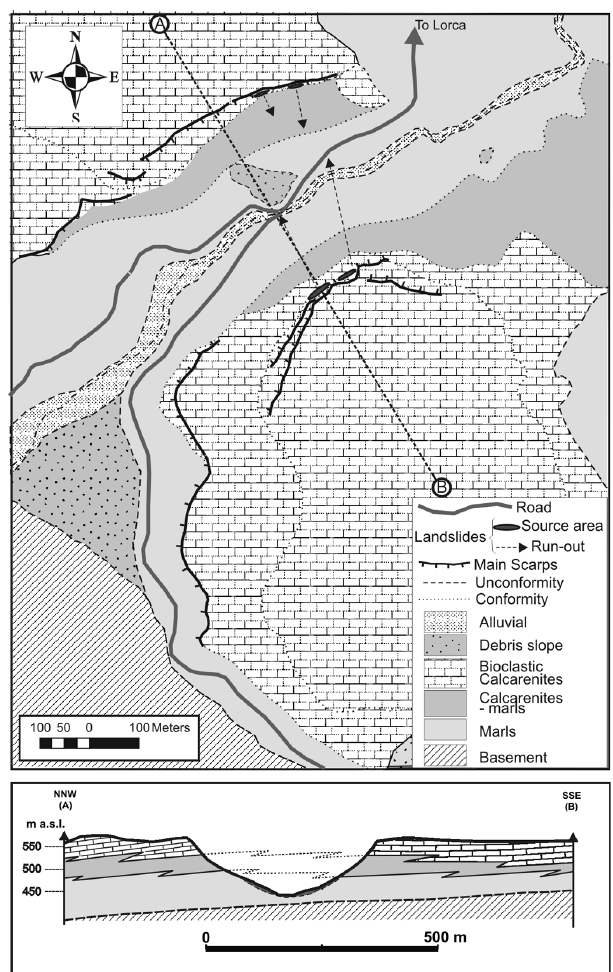
Fig. 2. Geological map and geological cross-section of the “Rambla de los diecisiete ojos”